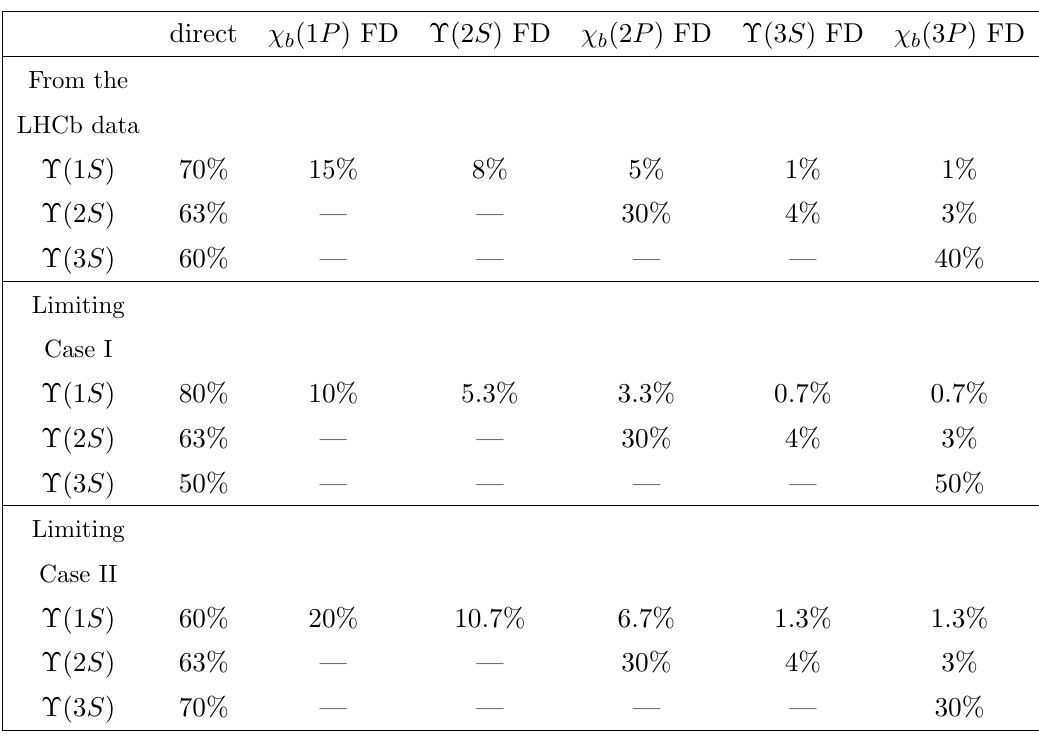
Table 2 . Expected (cid:7) FD contributions.